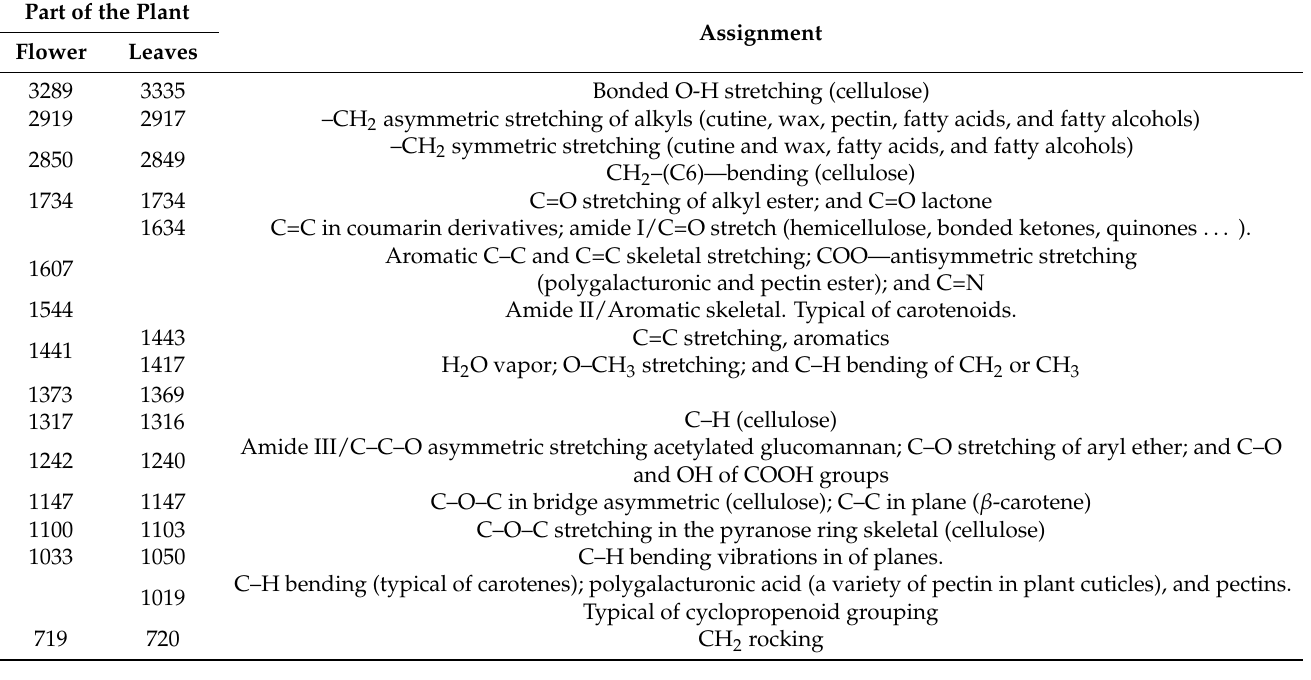
Table 2. Main bands in the ATR-FTIR spectra of Hibiscus syriacus flowers and leaves and their assignments. Peak positions are expressed in cm − 1 .